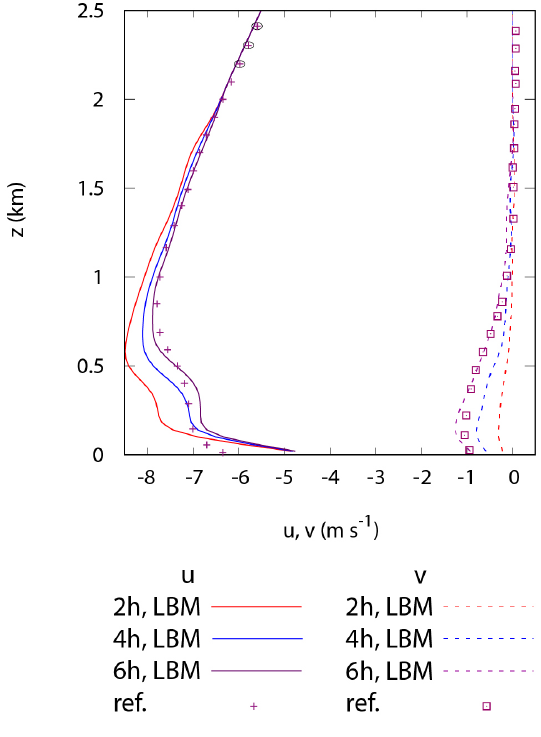
Figure 5. Reference and simulated profiles of mean velocity for the shallow cumulus convection